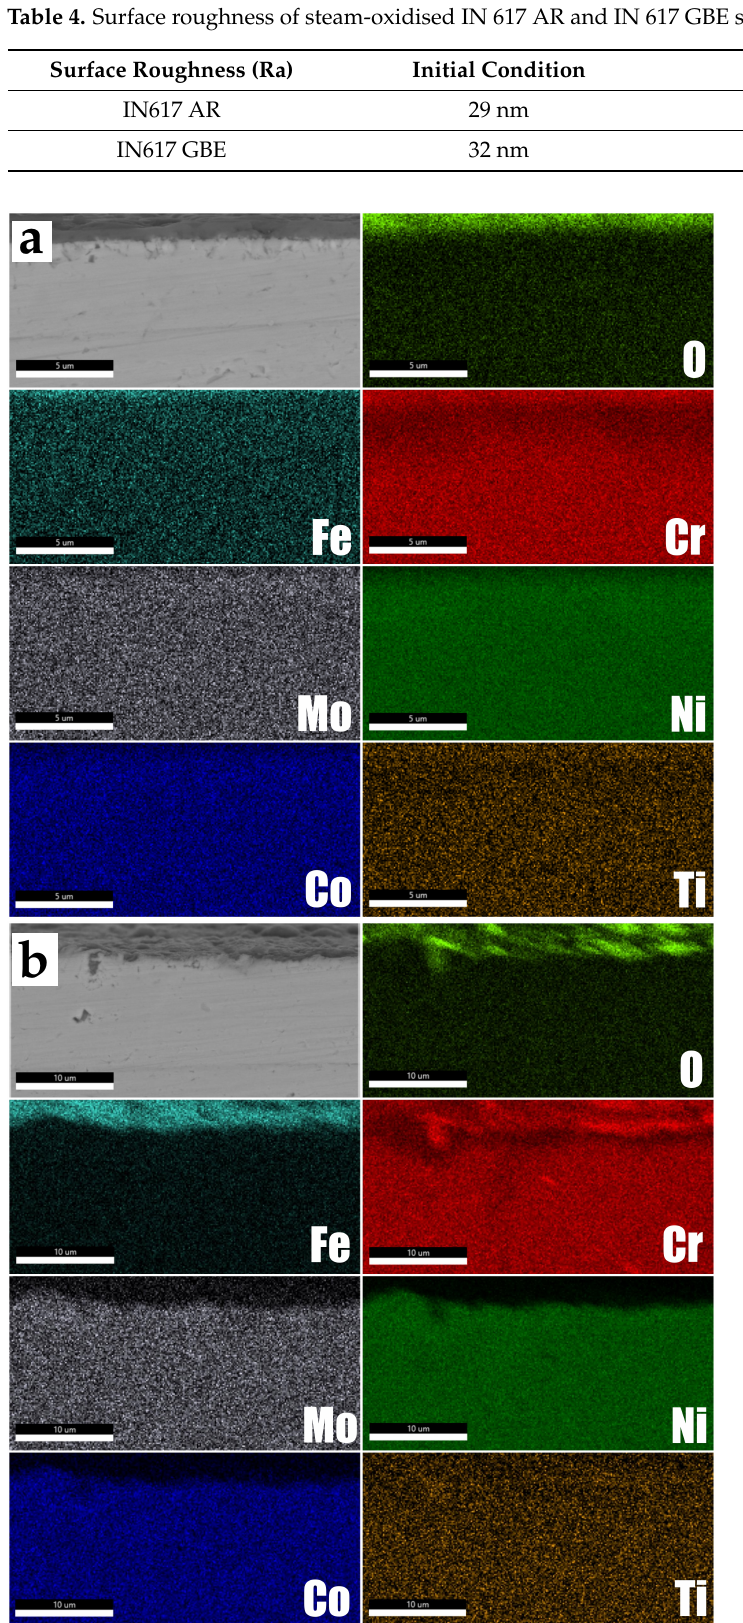
Figure 9. Cross-section SEM micrograph post-steam-oxidation of: ( a ) IN 617 AR; ( b ) IN 617